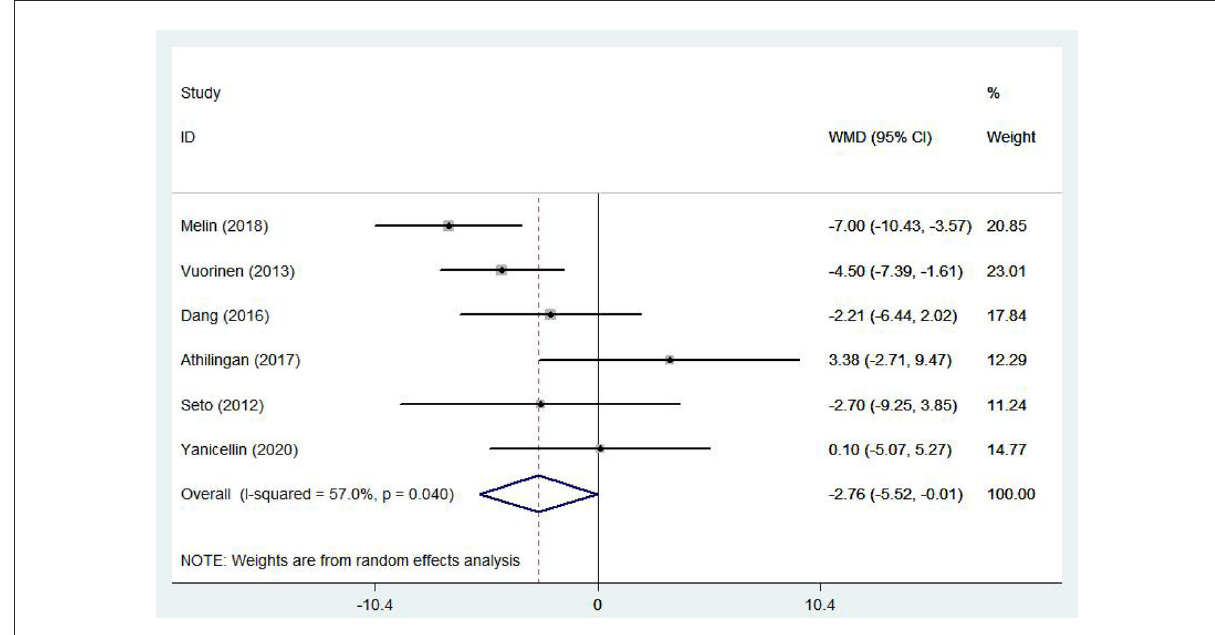
FIGURE12 Forest plots showing the effects of self-care behaviors.